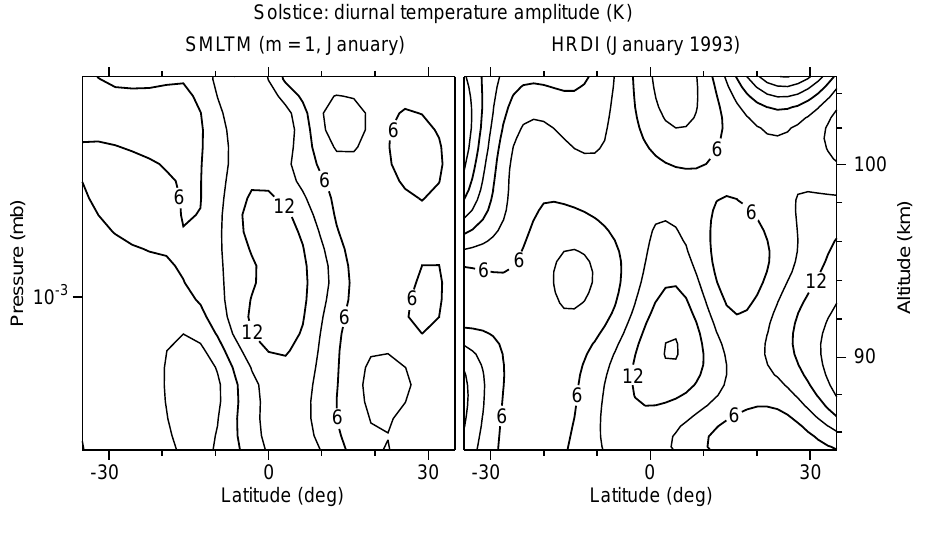
Fig. 6. Diurnal tidal amplitude for temperature (contour interval 3 K): SMLTM simulations ( m (cid:136) 1) for January ( left panel ); HRDI diurnal tidal amplitude for Janu- ary 1993 ( right